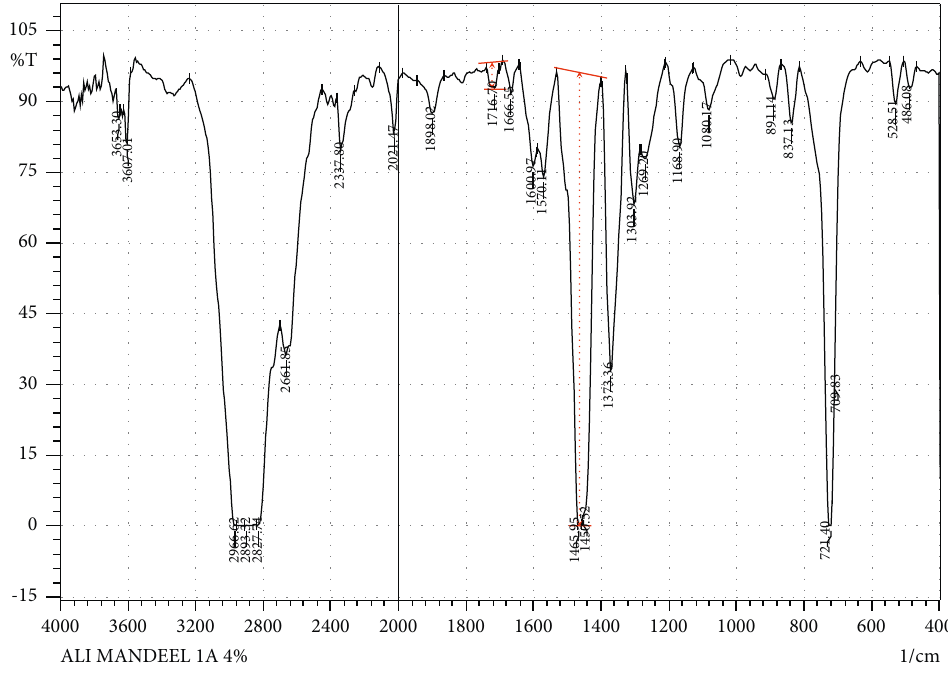
Figure 1: IR spectrum of the antioxidant-PE composite containing compound 1 (4%). Table 2: Effect of dose of curcumins 1–8 on the CI of the LDPE. Compound